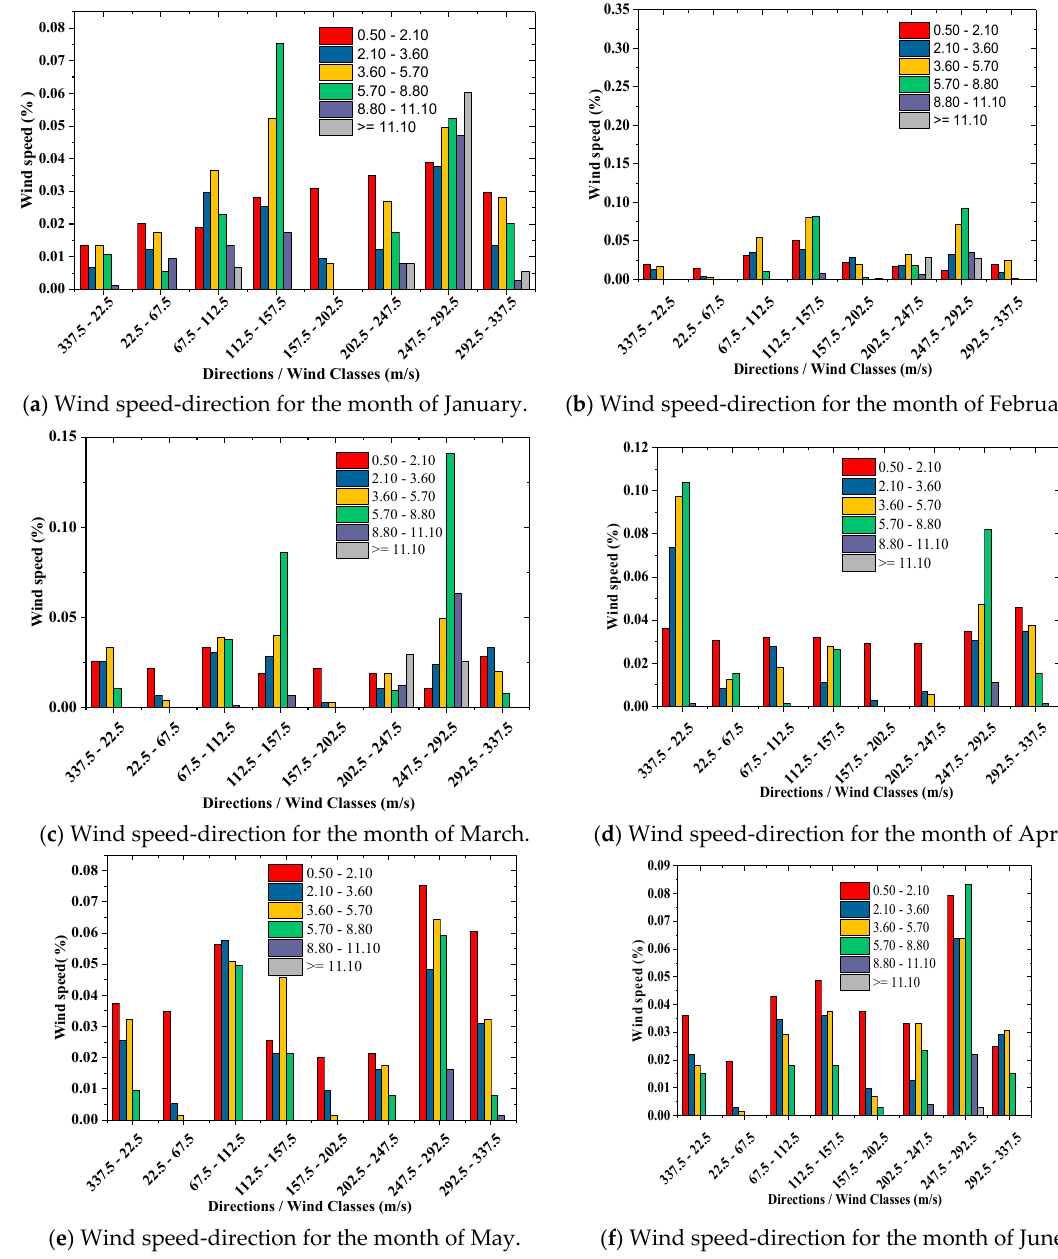
Figure 10. Wind speed-direction for the months from January to June in 2016 at 65 m.